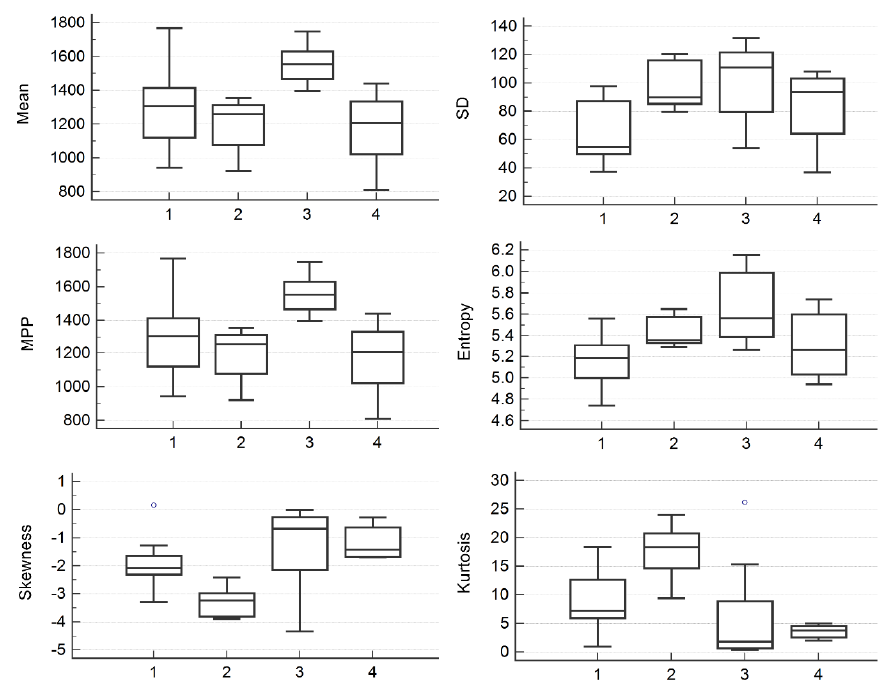
Figure 2. Box and whisker plots showing differences between median values of mean, SD, MPP, entropy, skewness, and kurtosis computed from raw images for the differentiation of functional cysts (1), serous cystadenomas (2), clear-cell carcinomas (3), and serous carcinomas (4). SD, standard deviation of pixel intensity; MPP, mean of positive pixels.